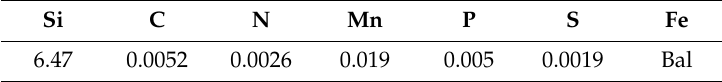
Table 1. Chemical composition of Fe-6.5wt.%Si alloy (wt.%).